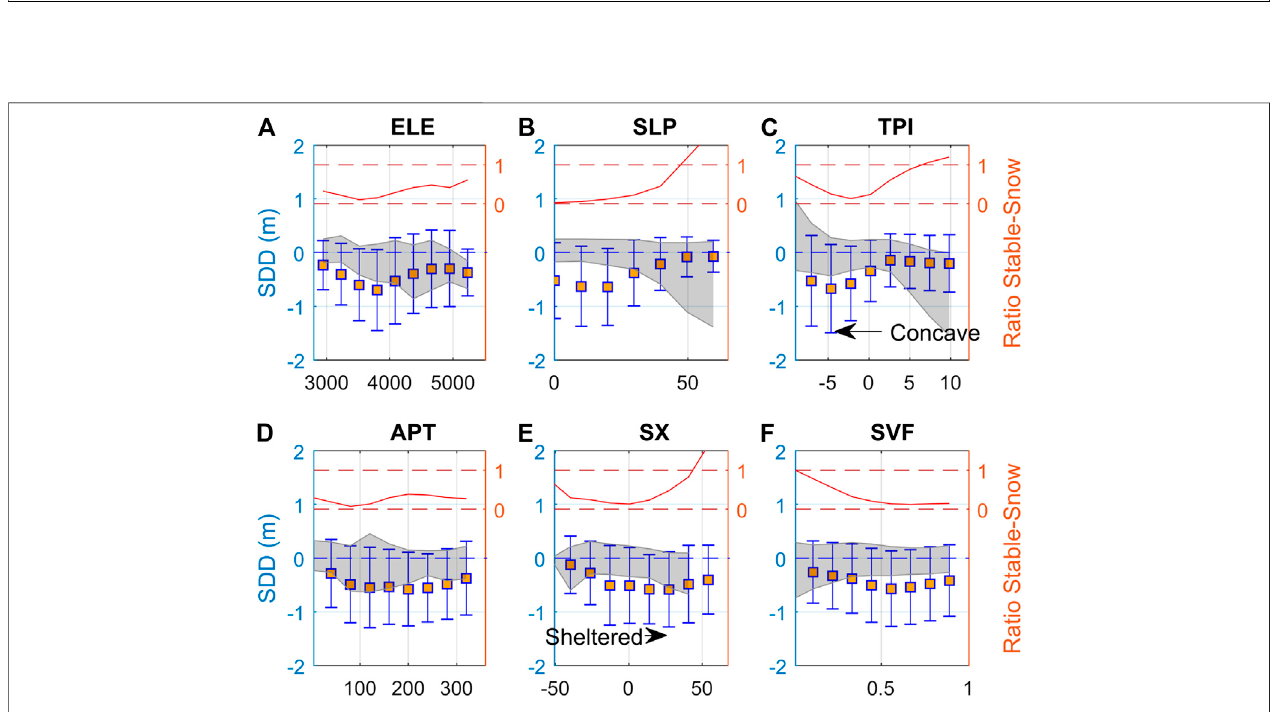
FIGURE 8 | The mean (orange boxes) and standard deviation (error bars) of snow depth in 10 equal bins of the topographic indices ofthe catchment (named as in Figure 7 ; Topographic Indices of the Digital Elevation Model ). The grey shaded area denotes the range of uncertainty in the stable terrain (d2DEM) for each bin of each index. Theright-handaxesrepresenttheratioofstabletosnowpixelsforeach binandindex(referenceof0and1givenbyhorizontaldashed lines).Lowratios arenoted to still have > 20,000 stable terrain pixels in total. Arrows for TPI and SX are used to clarify the meaning of positive and negative values for those indices.